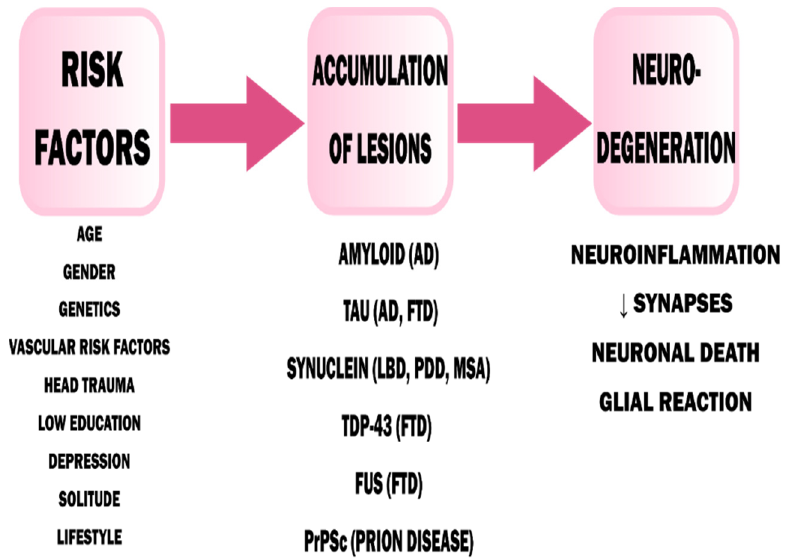
Figure 1. Pathophysiology of dementia [17]. AD—Alzheimer’s Disease, FTD—Frontotemporal Dementia, LBD—Lewy Body Dementia, PDD—Parkinson’s Disease Dementia, MSA—Multiple System Atrophy. Adapted from Saladrini, A., Seminars in Neurology; published by Thieme Medical Publishers, 2019.